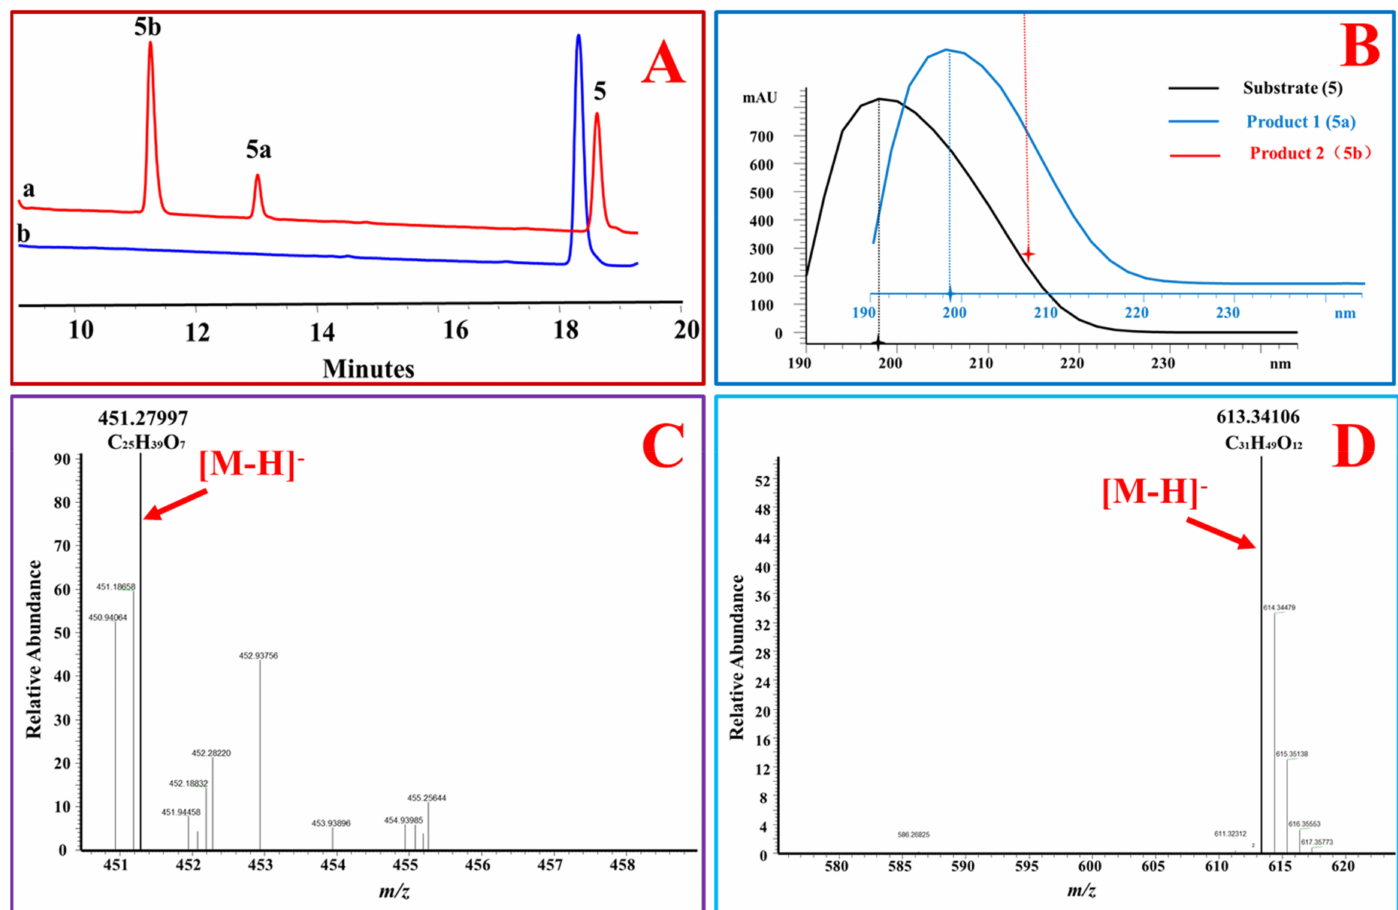
Figure 2. OcUGT1-catalyzed glucosylation of 4-androstenediol ( 5 ). ( A ) HPLC profiles of 4-androstenediol ( 5 ) glucosylation. ( a ) the reaction mixture of 4-androstenediol ( 5 ) with the purified OcUGT1; ( b ) the reaction mixture of 4-androstenediol ( 5 ) without the purified OcUGT1; 5 , 5a, and 5b refer to 4-androstenediol ( 5 ) and its mono-glucoside and bioside, respectively. ( B ) UV spectra of 4-androstenediol ( 5 ) and its glucosides. ( C ) HR-ESI-MS spectrum of 4-androstenediol mono-glucoside ( 5a ). ( D ) HR-ESI-MS spectrum of 4-androstenediol bioside ( 5b